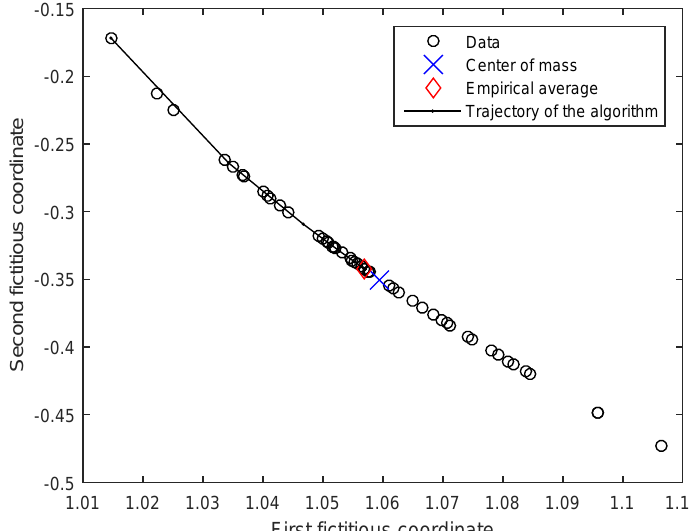
Figure 1. Numerical test of function minimization applied to the criterion function in Equation (28) over the pseudo-orthogonal group O ( 1,1 ) : Data set and result of mean-matrix computation. (To obtain an easy-to-read graph, we chose to represent a pseudo-orthogonal matrix X ∈ O ( 1,1 ) , which is a 2 × 2 matrix, by two fictitious coordinates, namely the entry X ( 1,1 ) as first coordinate and the entry X ( 1,2 ) as second